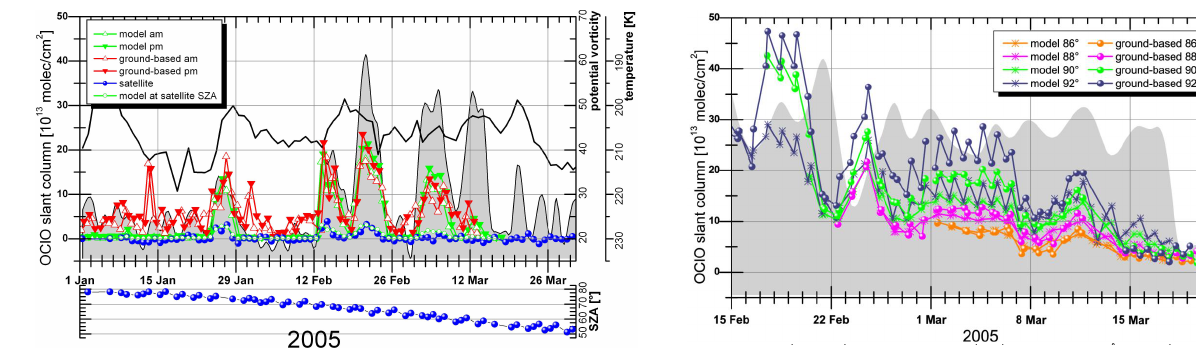
Fig. 5. OClO over Bremen (53 ◦ N, 9 ◦ E; axis on the left): Model (green triangles) and ground-based data (red triangles) at 90 ◦ SZA and satellite (blue dots) at the SZA given below as well as model at the SCIAMACHY SZA (green circles), potential vorticity (shaded area) and temperature (black line) at the 475K isentropic surface.